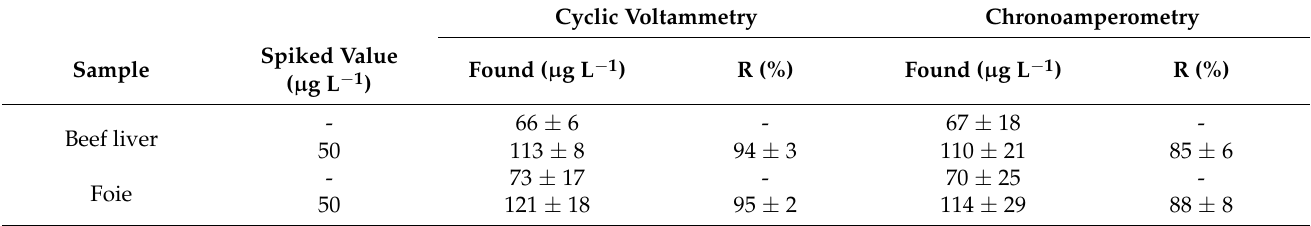
Table 3. Analytical results obtained in the analysis of two spiked samples by the analytical method proposed using external calibration. The concentration and recovery values are expressed as the mean ± standard deviation of three replicates. Cyclic Voltammetry Chronoamperometry